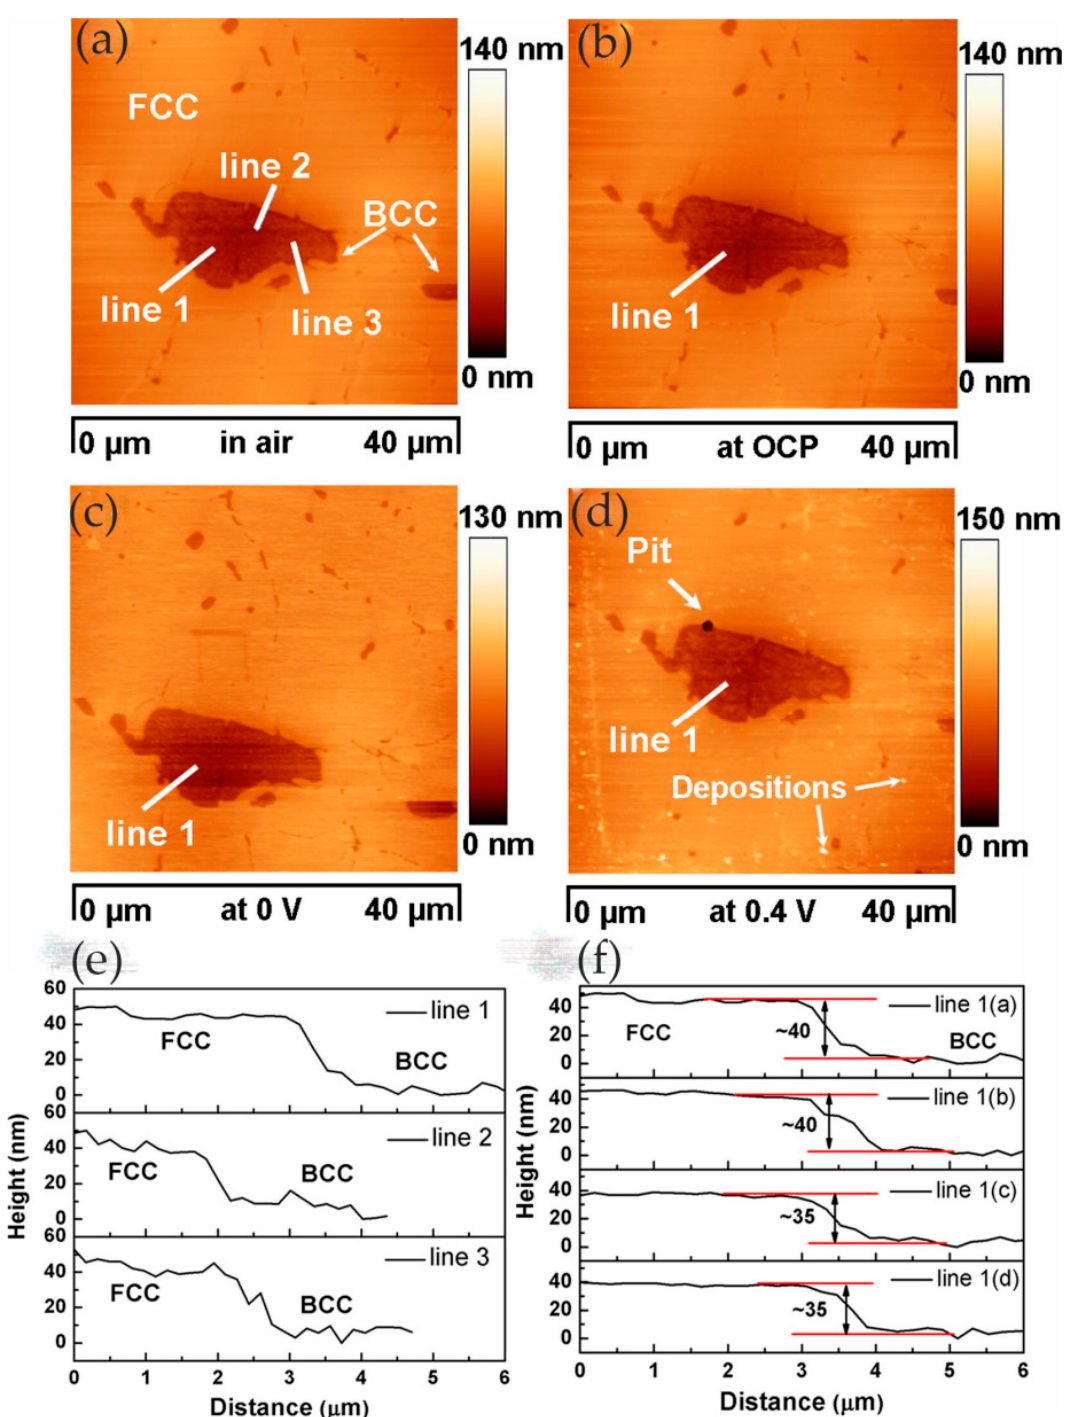
Figure 26. The AFM topography image in air ( a ), and in situ EC-AFM topography images of the Al 0.5 CoCrFeNi HEA after 10 min of exposure in a 3.5 wt. % NaCl solution at ( b ) OCP, ( c ) 0 V, and ( d ) 0.4 V. ( e ) Three-line profiles across the phase boundaries illustrated in ( a ). ( f ) Vertical profiles along line 1 of the surface in ( a – d ). Reprinted with permission from Reference [63]; copyright 2018 Elsevier Ltd.